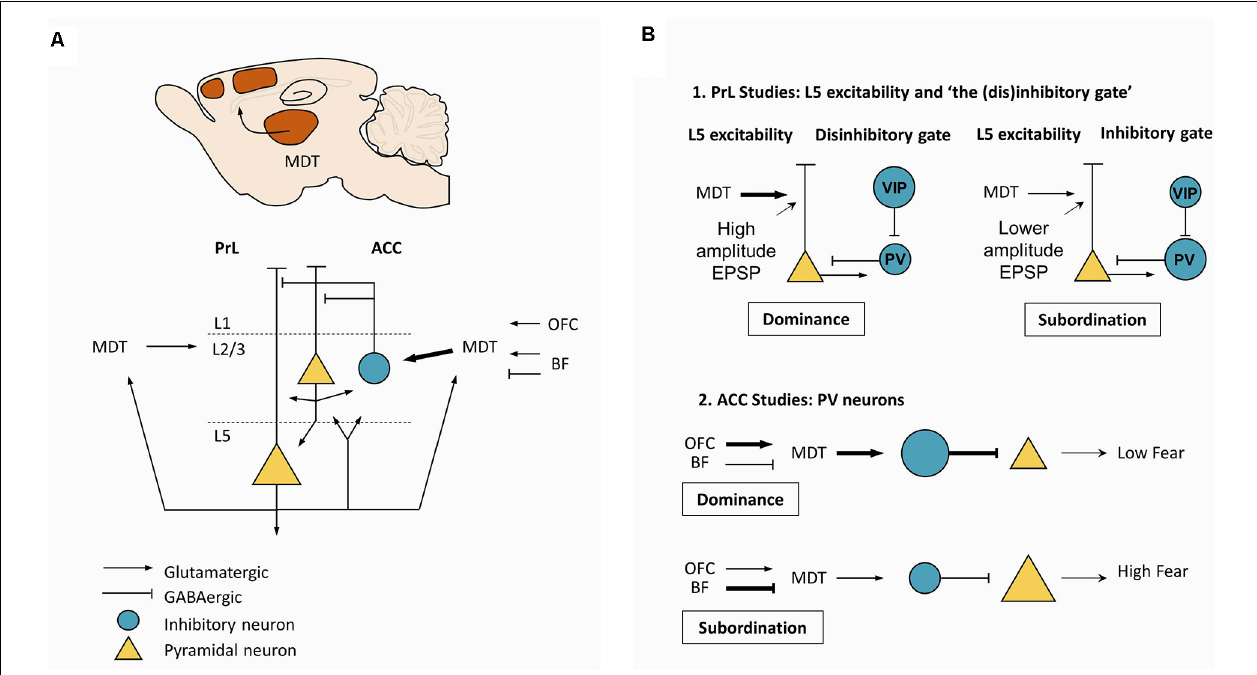
FIGURE 3 | Mesoscale mechanisms supporting dominance. (A) Canonical circuit in PrL and ACC. Glutamatergic neurons from MDT project strongly to L2/3 PV neurons in ACC, with a less dense projection to L2/3 in PrL. Depolarization of MDT neurons is determined by excitatory projections from OFC, L5 pyramidal neurons from PrL and ACC, and from excitatory and inhibitory projections from the BF. (B) Two major types of studies to explain dominance. (B-1) Studies in the PrL support the central role of MDT. Strong excitatory drive coming from MDT is thought to favor effortful, persistent behavior by increasing the excitability in L5 pyramidal neurons. Potentiation of MDT-PrL synapses by repeated winning and activation is thought to increase the probability of winning, triggering a “winner effect”. In addition, a disinhibitory gate may also contribute to regulating the excitability of L5 pyramidal neurons. Specifically, increased activity in the VIP interneurons would open the gate by inhibiting PV interneurons, leading to increased excitability in L5 pyramidal neurons, favoring dominance. On the other hand, increased activity in PV interneurons would close the gate, leading to decreased excitability in L5 pyramidal neurons, favoring subordination. (B-2) Studies in the ACC suggest that high MDT excitability and firing due to a strong excitatory drive coming from the OFC would lead to increased depolarization of PV neurons, decreasing fear expression. These hypotheses suggest that differences in synaptic plasticity and neuronal excitability per se could explain dominance among rodents. Plasticity and excitability are prone to genetic influences and environmental effects, including hormones and degree of behavioral training. Abbreviations: PrL, prelimbic cortex; ACC, anterior cingulate cortex; MDT, mediodorsal thalamus; PV, parvalbumin; OFC, orbitofrontal cortex; BF, basal forebrain; VIP, vasoactive intestinal